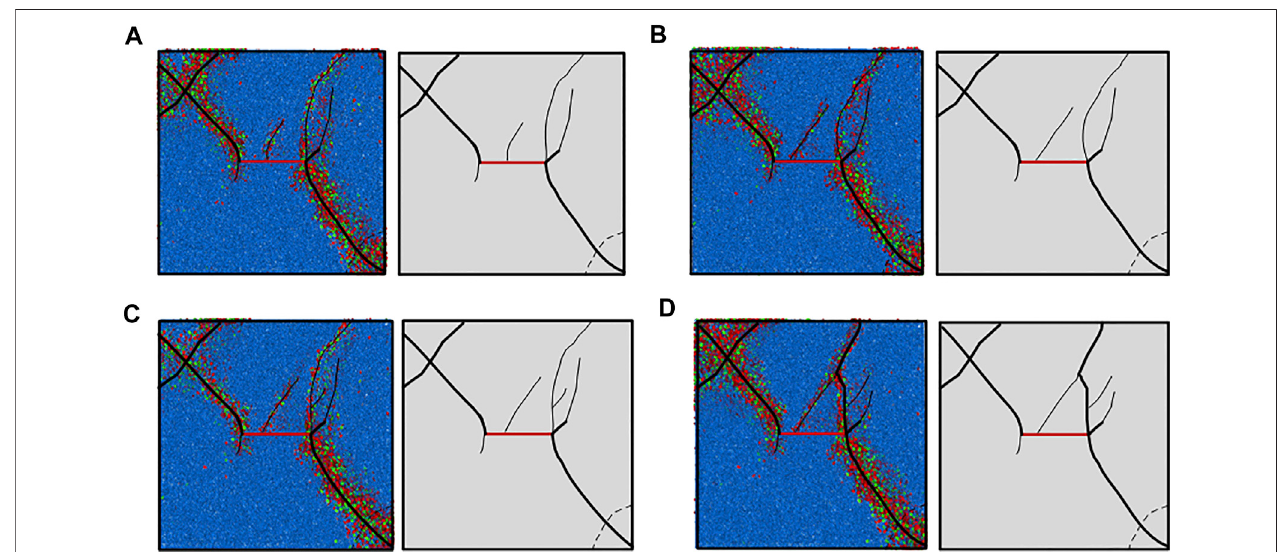
FIGURE12| Simulationresultsandsketchofspecimensunderdifferentporewaterpressures. (A) 0.5 Mpaporewaterpressure; (B) 1.0 Mpaporewaterpressure; (C) 1.5 Mpa water pressure; and (D) 2.0 Mpa water pressure.